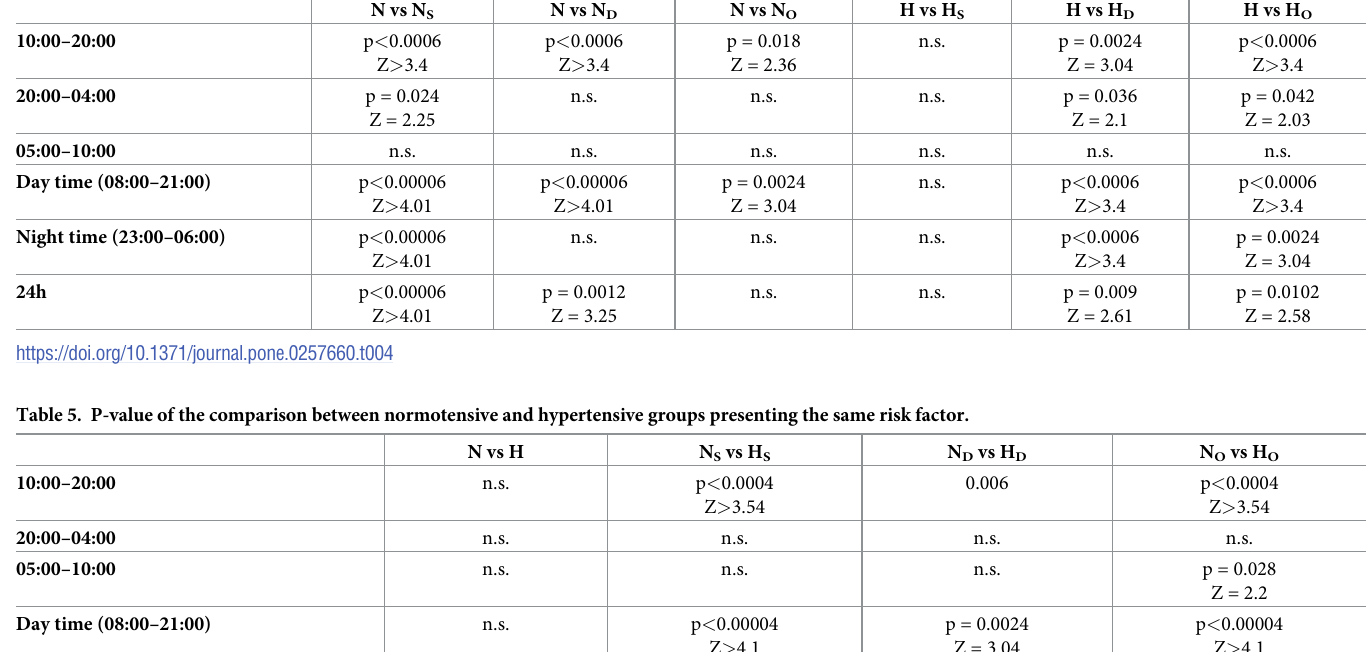
Table 4. P-value of the comparison between normotensive and hypertensive groups with and without risk factors. N vs N S N vs N D N vs N O H vs H S